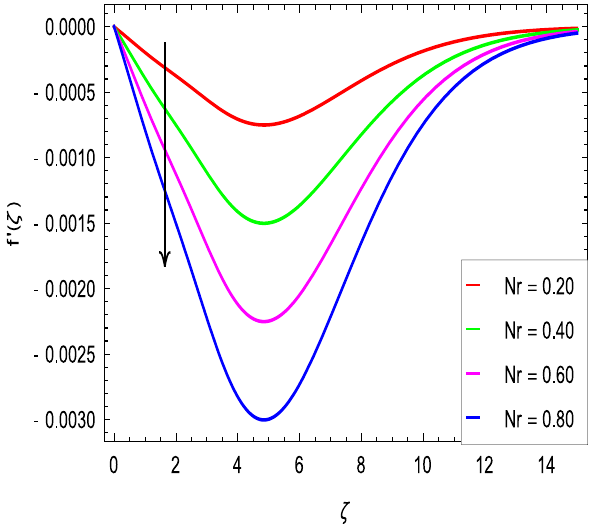
Figure 6. f ′ (ζ) in terms of Nr .